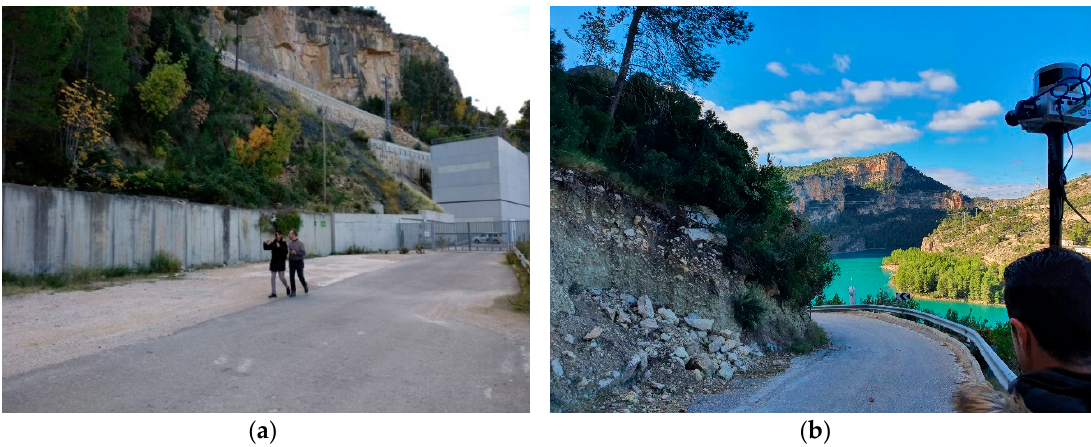
Figure 6. Two sequences of the MMS (Mobile Mapping System) survey with Kaarta Stencil 2. ( a ) Lower part and ( b ) upper part of the rockwall.